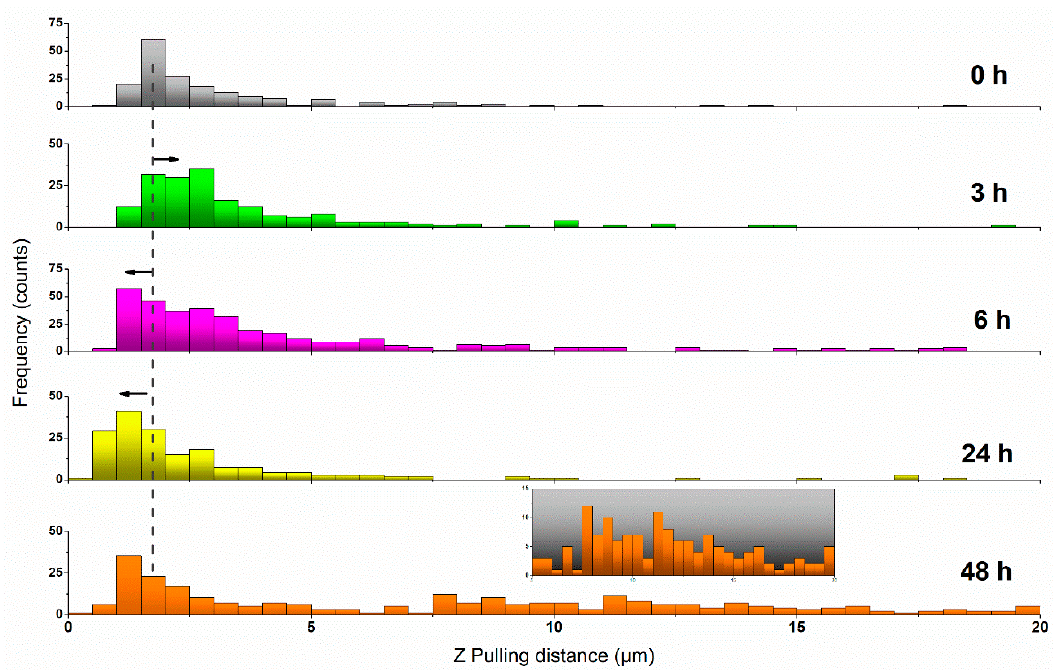
Figure 5. Histogram plot showing the distribution of appearing distances for the rupture events under increasing resveratrol incubation times. The dashed line provides a visual reference for the comparison with the most probable pulling distance obtained for untreated MCF-7 cells. Black arrows indicate the sense of the variation registered. The inset for t = 48 h magnifies the pulling range Z = 5 − 20 µ m, corresponding to the appearance of a second population of cells.